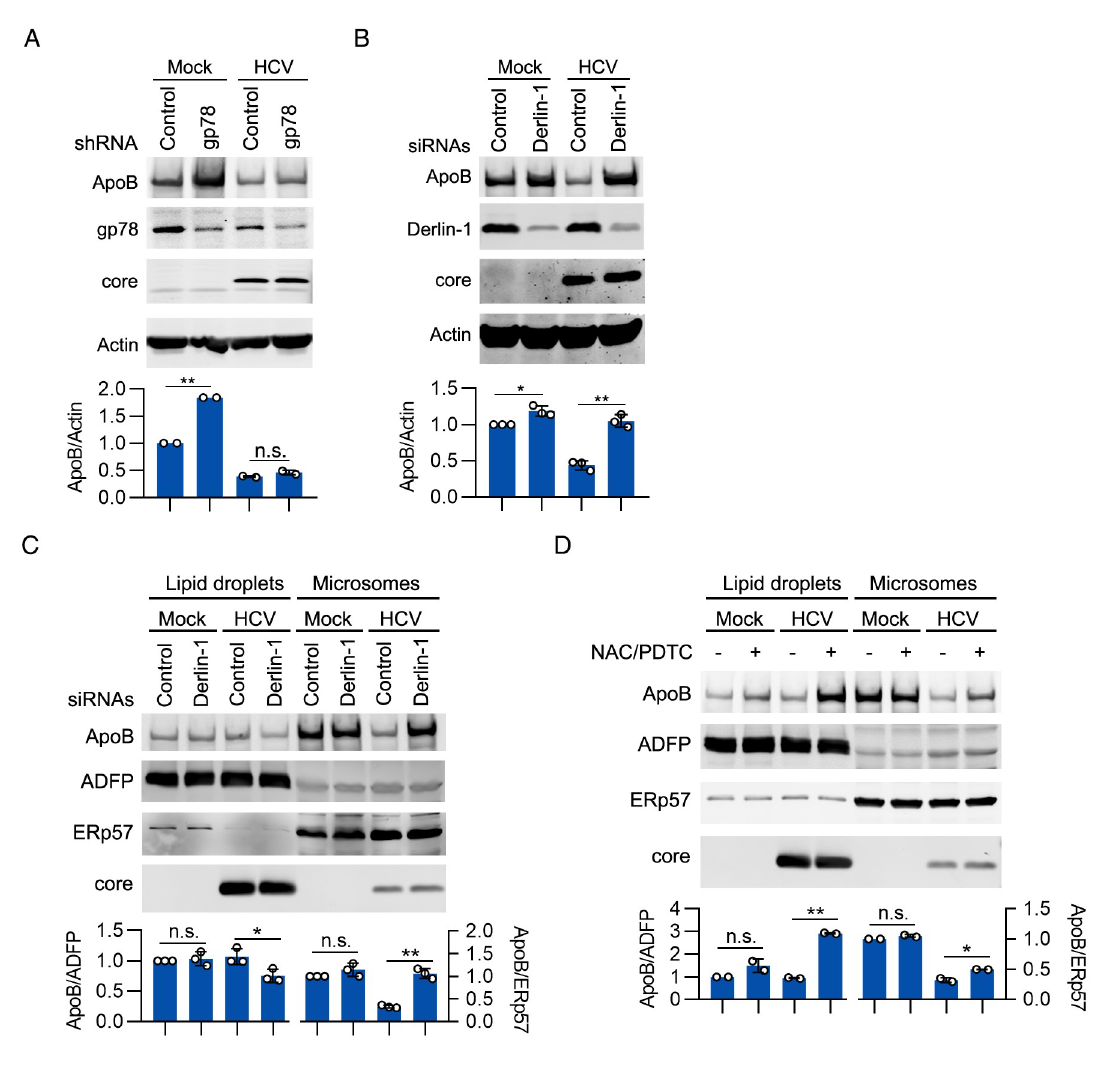
Fig 7. Derlin-1 but not gp78 participated in ApoB degradation. (A) Huh-7 cells were infected with HCV (MOI = 1) for 2 days followed by transduction with gp78 shRNA for 2 days. The protein levels of ApoB, gp78, and core were analyzed by western blotting at 4 days after infection. Actin was used as the loading control. (B) Huh-7 cells were infected with HCV (MOI = 1) for 2 days followed by transfection with Derlin-1 siRNAs for 2 days. The protein levels of ApoB, Derlin-1, and core proteins were analyzed by western blotting at 4 days after infection. Actin was used as the loading control. (C) Huh-7 cells were infected with HCV (MOI = 1) for 2 days followed by transfection with Derlin-1 siRNAs for 2 days. The protein level of ApoB was analyzed in LD fractions and microsomal fractions. ADFP and ERp57 were used as loading controls. (D) Huh-7 cells were infected with HCV for 4 days prior to treatment with 1 mM NAC and 100 μ M PDTC for 12 hours. The protein level of ApoB was analyzed in LD fractions and microsomal fractions. ADFP and ERp57 were used as loading controls. The data are presented as the means ± SDs from densitometry analyses of n = 2 or 3 independent experiments, and representative gels for each specific assay are shown. The statistical significance was determined by unpaired two-sided Student’s t -tests. n.s., not significant. � P < 0.05. �� P <